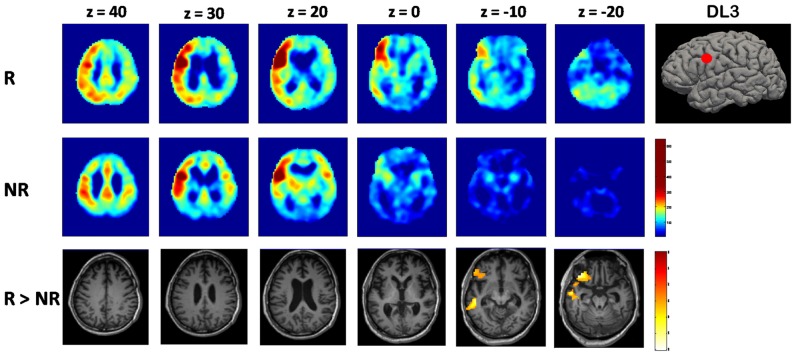
Voxel-wise maps of functional connectivity of the left dorsolateral prefrontal cortex (DLPFC; DL3) seed. A brain volume rendering with the cortical DL3 seed position is represented on the right. Each map is resulting from averaging across subjects of each group (responders (R) and non-responders (NR)). Functional connectivity intensity at each voxel is represented as the pearson’s correlation coefficient between the rs-fMRI signal of the DL3 spherical ROI and the voxels of the rest of the brain. On the bottom line, brain areas showing higher coactivation with DL3 seed in six tDCS responders vs. 10 tDCS NR (R > NR; results are family wise error (FWE) corrected for multiple comparisons).